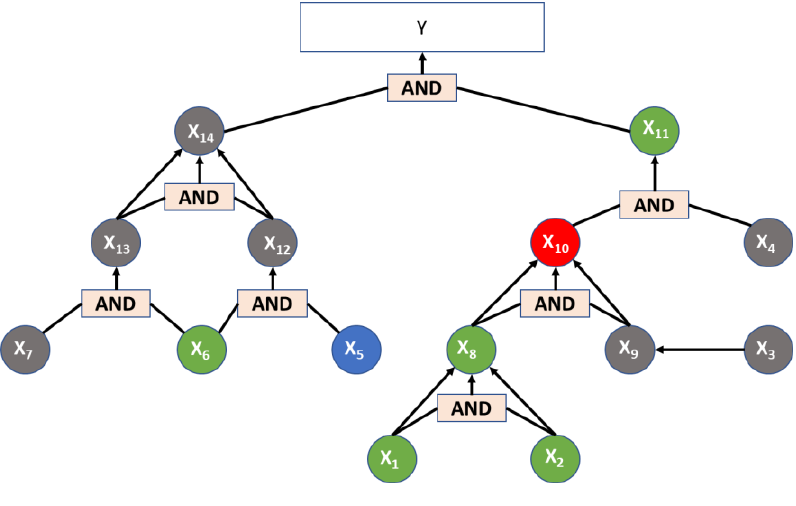
Figure 11. Un-labeled structure.